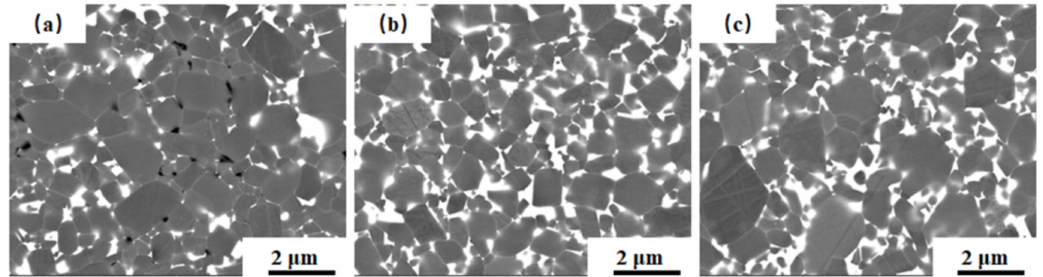
Figure 8. Polished surfaces of sintered SiC samples at 1950 ◦ C, with di ff erent sintering additives